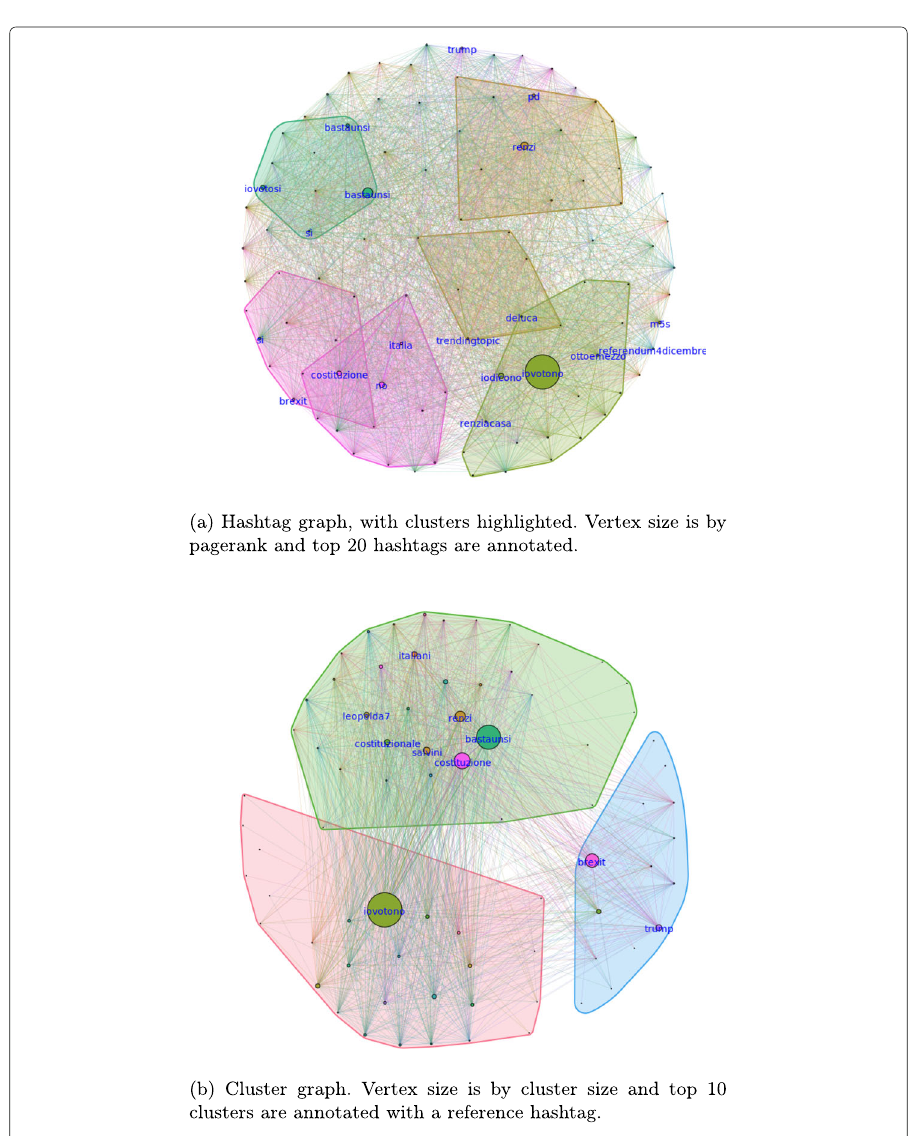
Fig. 1 The hashtag graph and the associated cluster graph